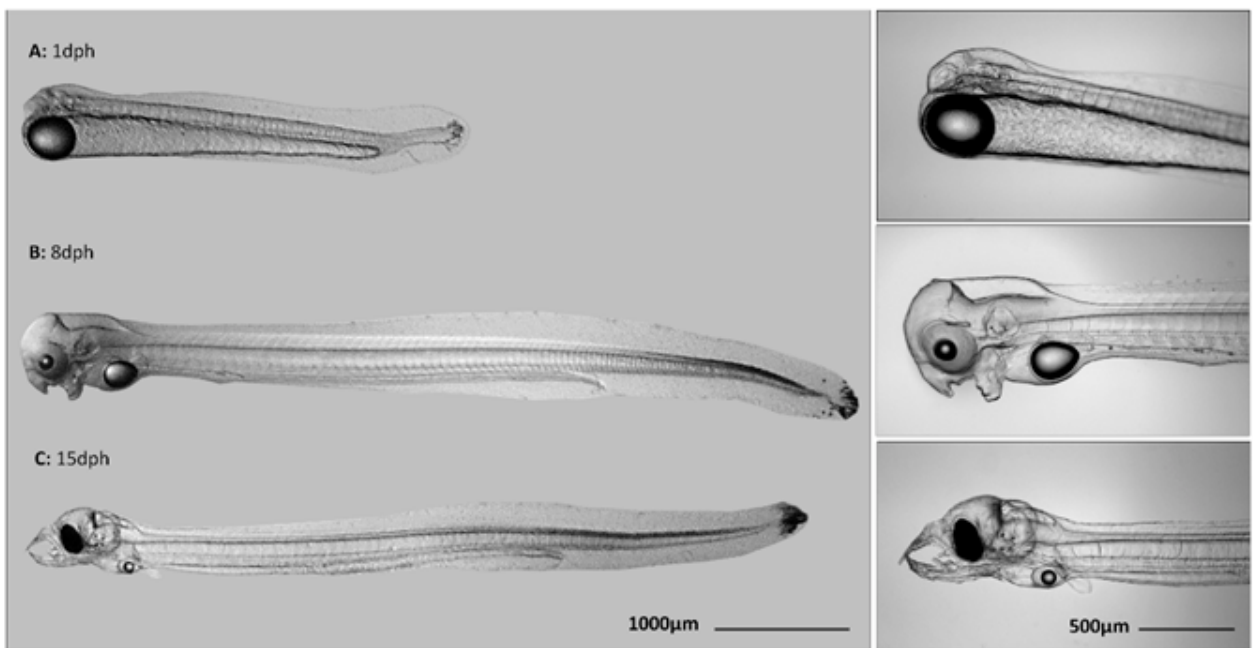
Figure 1. Larvae of European eel Anguilla anguilla at ( A ) one day post hatch (dph); ( B ) 8 dph, and ( C ) 15 dph. At 1 dph, new hatchlings hang in the water column with large yolk-reserves. At 8 dph, larvae start swimming and develop upper and lower jaws. Eyes become pigmented. At 15 dph, larvae swim actively. Yolk-reserves are almost depleted, the protruding teeth are formed, and larvae should start exogenous feeding. Eyes are completely pigmented.